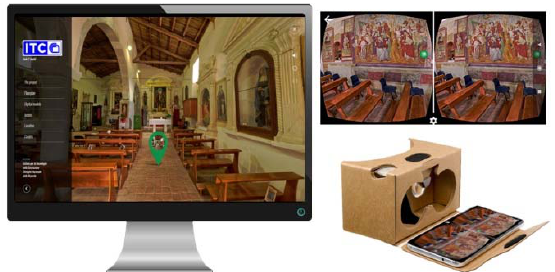
Figure 7. Different devices for the virtual tour.